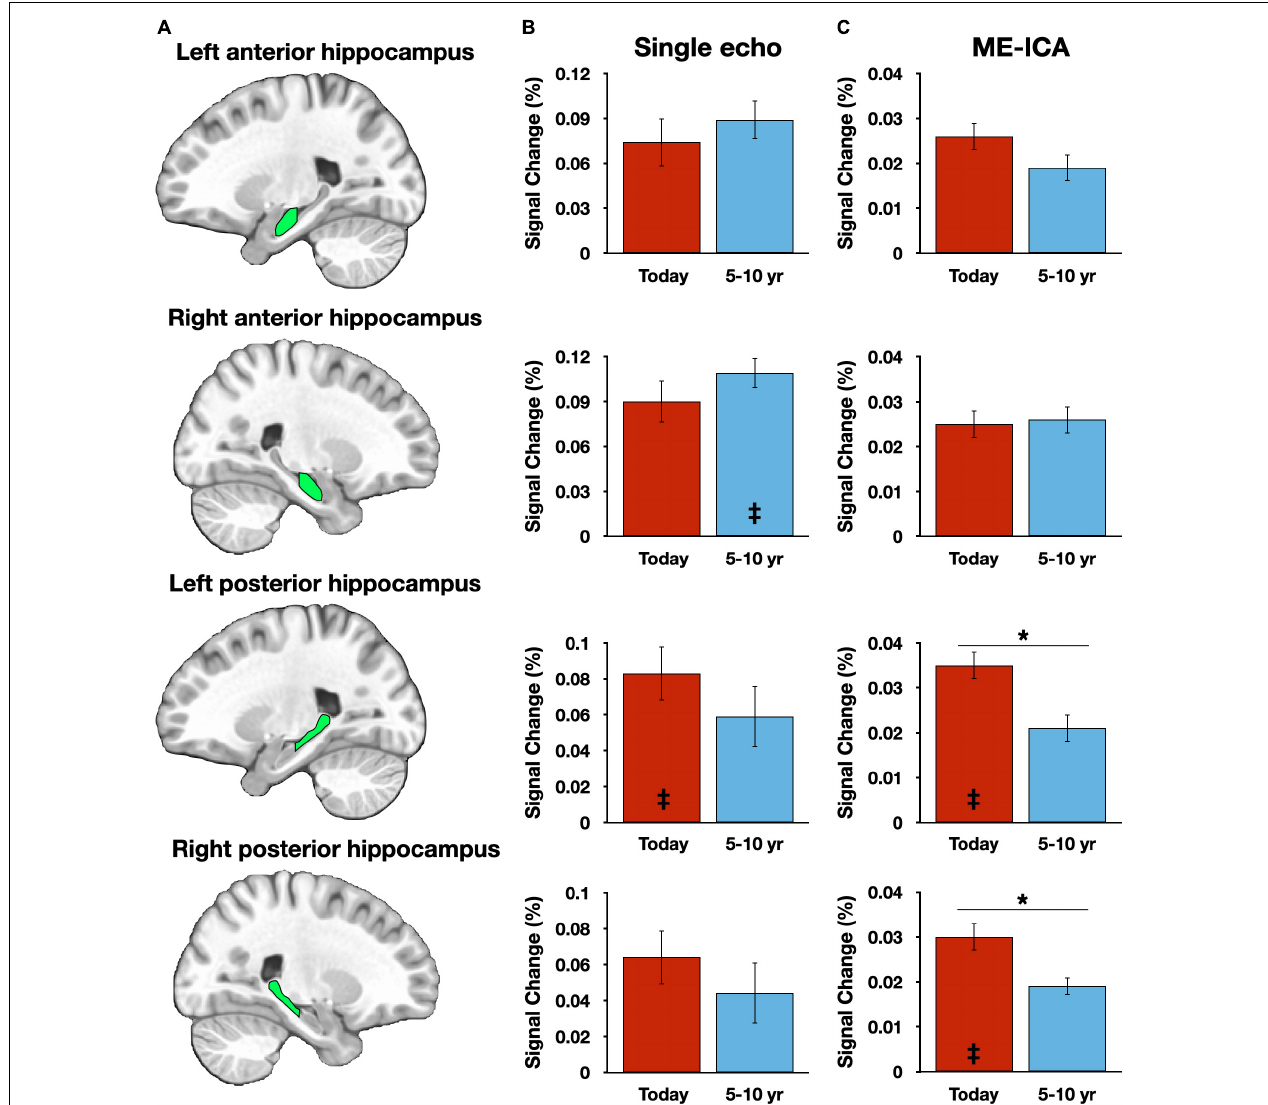
FIGURE 2 | Hippocampal results vary across preprocessing streams. (A) Graphic depictions of each manually defined hippocampal subregion. (B) Magnitude estimates from the single-echo (SE) analysis pipeline, plotted against the Picture Description control task. (C) Magnitude estimates from the multi-echo independent components analysis (ME-ICA) pipeline, plotted against the Picture Description control task. Asterisks (*) denote p < 0.05. Inset double daggers signify a significant difference from the Picture Description control task (corrected for multiple comparisons). Error bars reflect within-subject standard error.